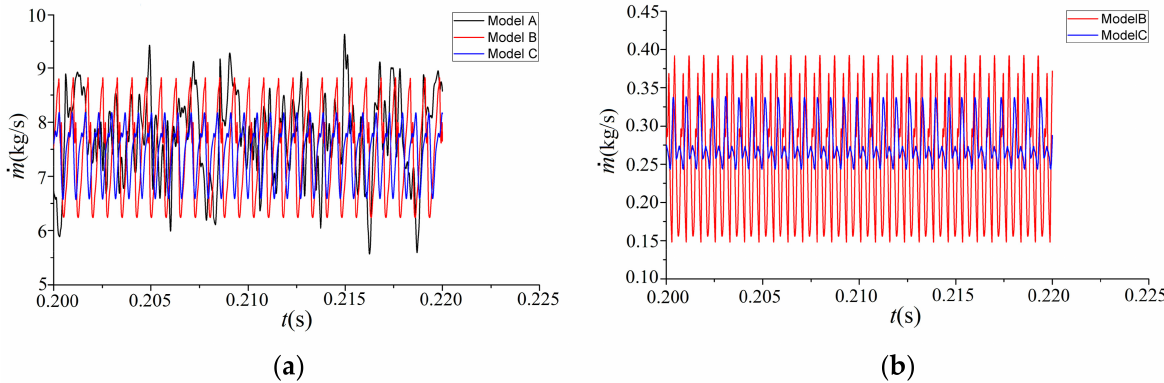
Figure 10. Variation of flow over time. ( a ) Export flow. ( b ) Rate of